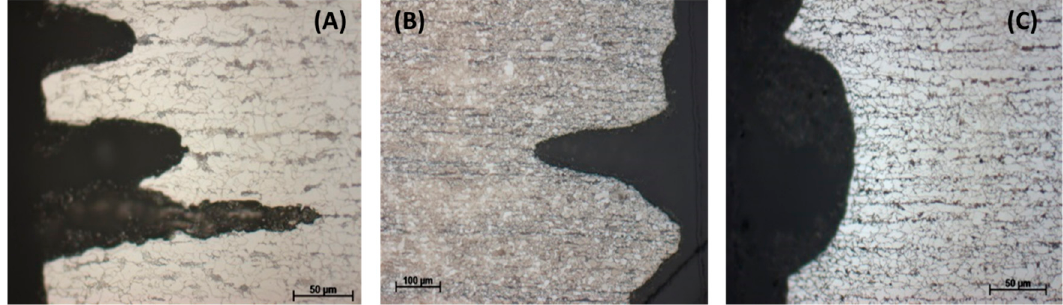
Figure 17. Effects of renewal condensate during 7 days of exposure tests. ( A ) Without changing the condensate, ( B ) with the change of condensate on the 3rd day and ( C ) with the changes of condensate on 2nd and 5th days. Condensate contains 0.0184 M HNO 3 and 0.114 M H 2 SO 4 .